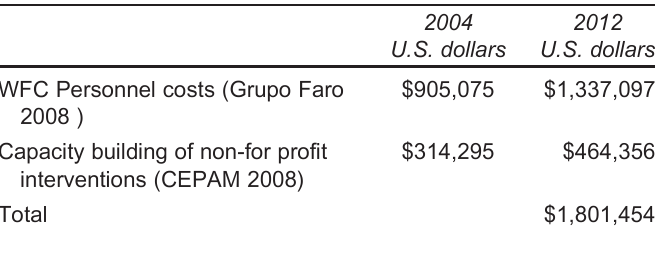
Table 5. Direct costs of legal services: Women and Family Commissaries (WFC) public and nonprofit